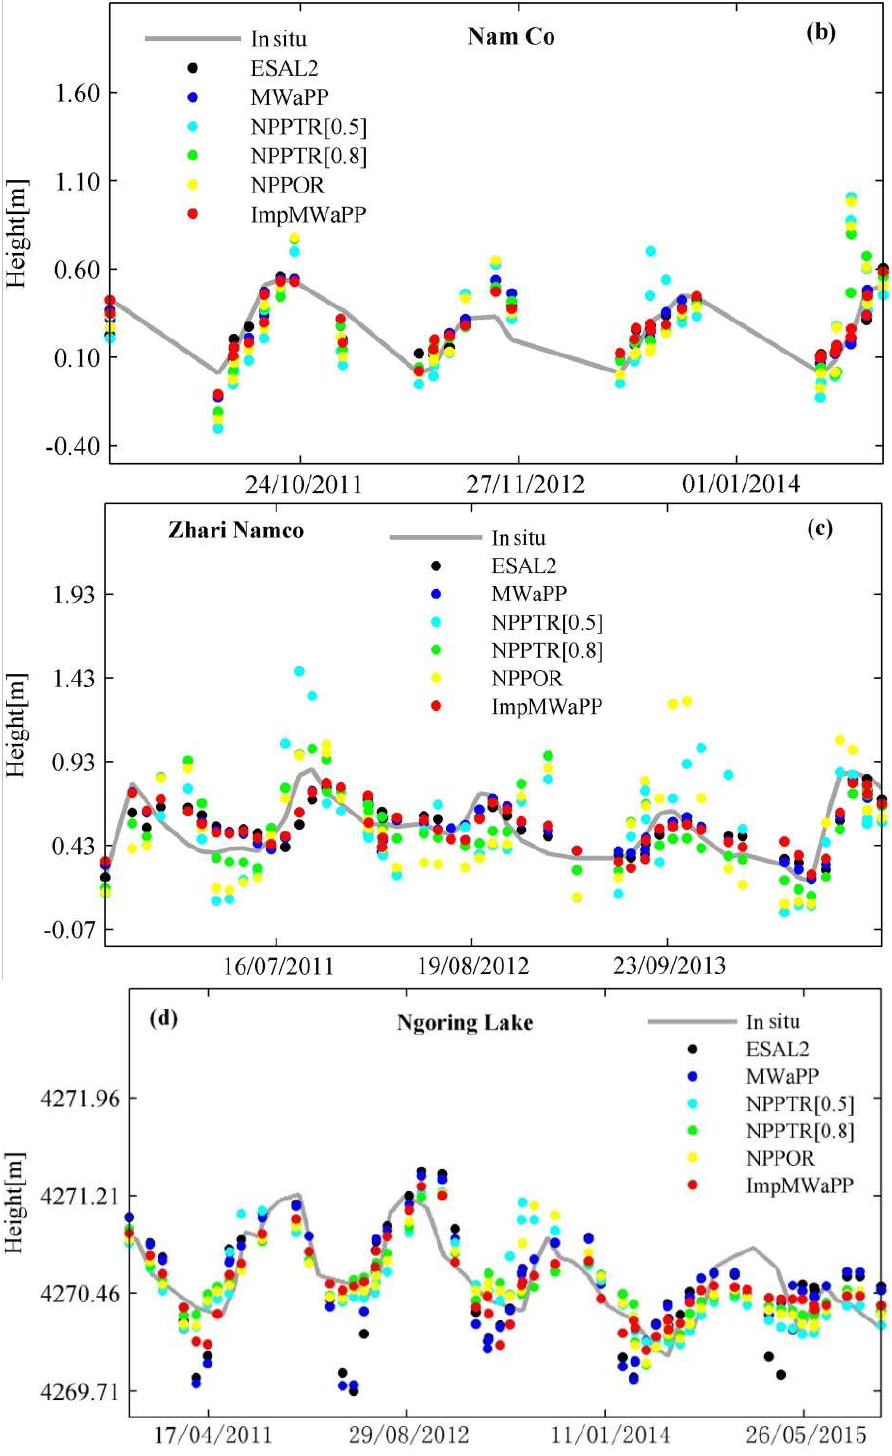
Figure 9. Cryosat-2 time series for four lakes obtained from different retrackers and compared with the in situ data: ( a ) Qinghai Lake; ( b ) Nam Co; ( c ) Zhari Namco; ( d ) Ngoring Lake.